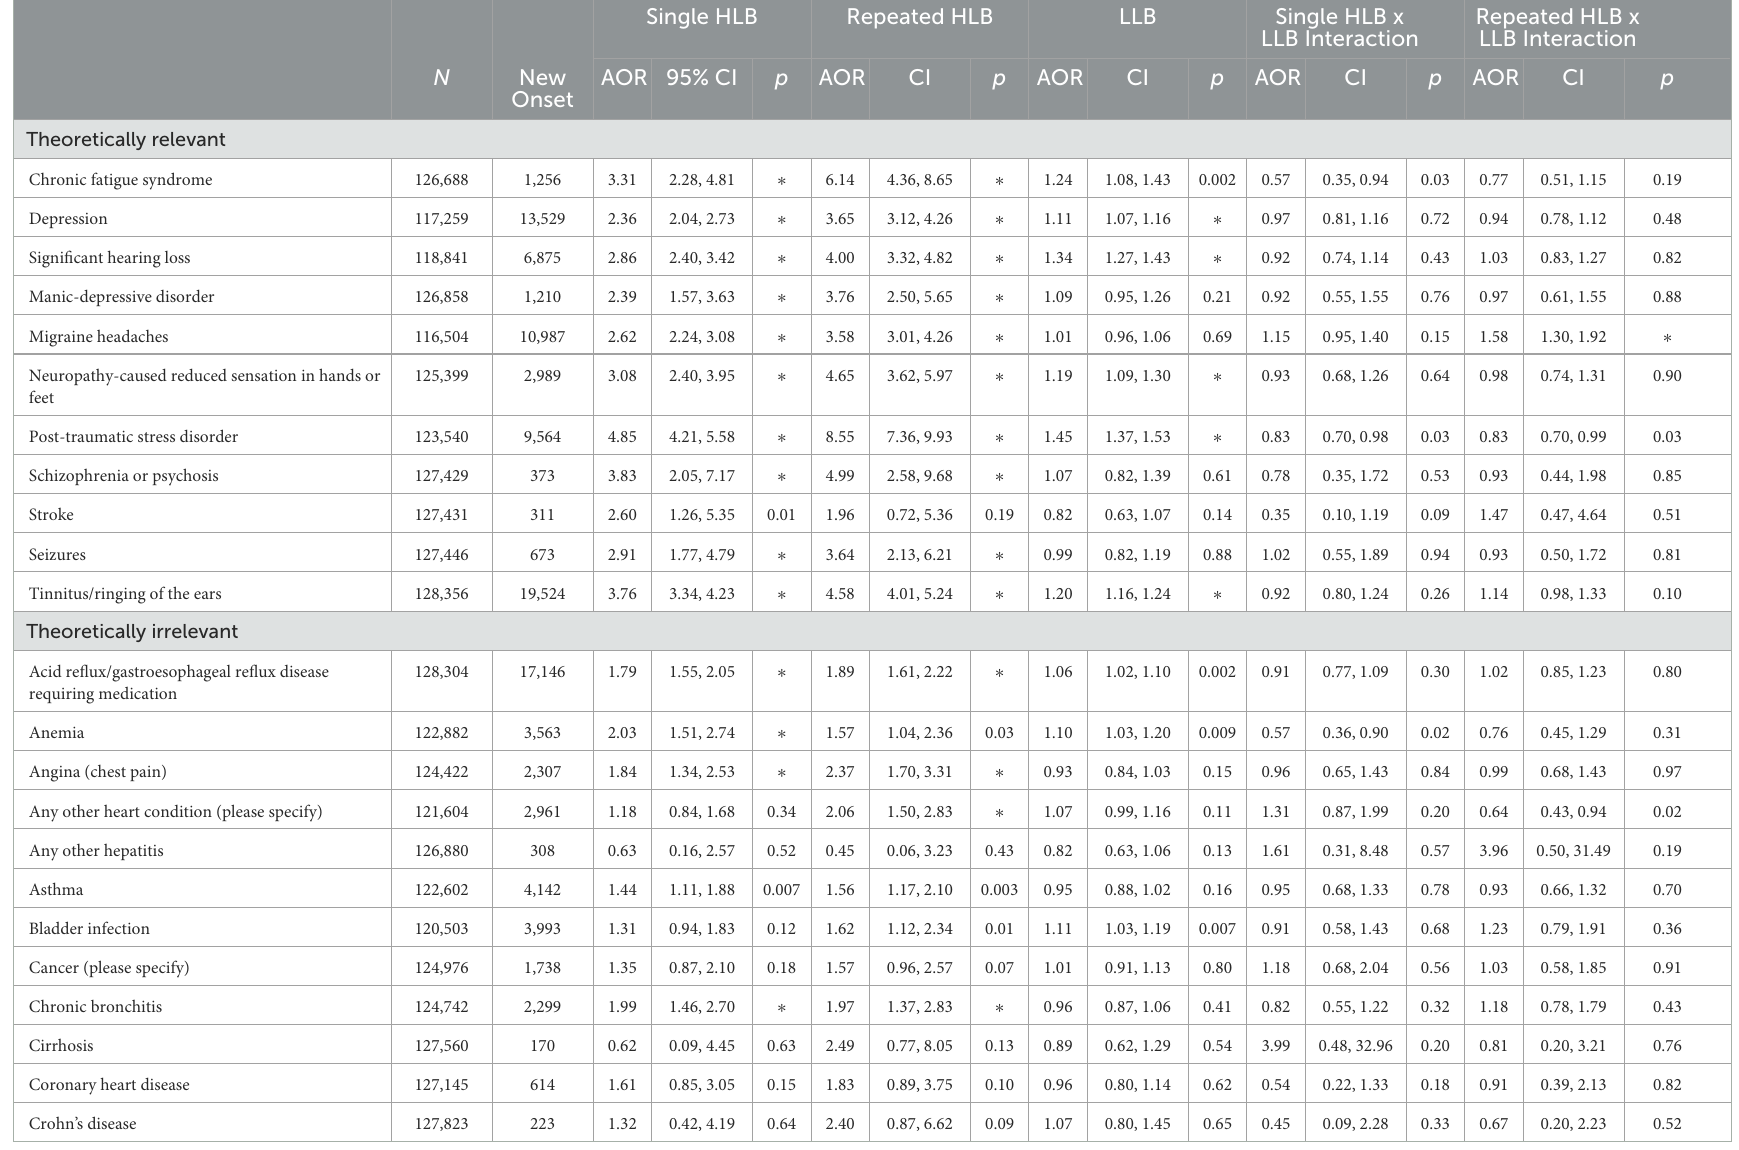
TABLE 2 Effect estimates for levels and 2-way interactions of HLB and LLB exposures.